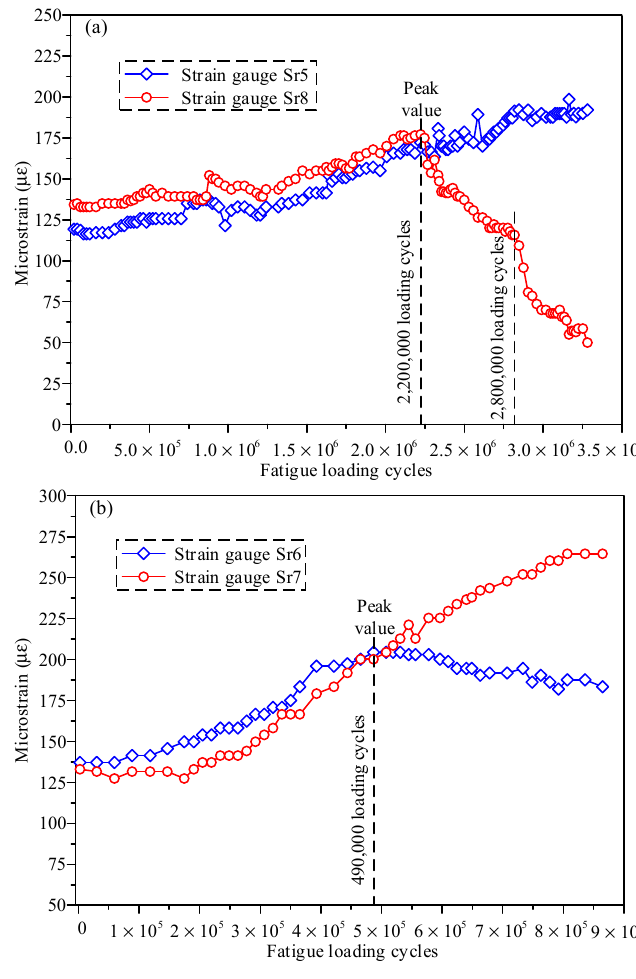
Figure 8. Strain gauges data of the specimens in the fatigue test: ( a ) strains of specimen S-1; ( b ) strains of specimen S-2.